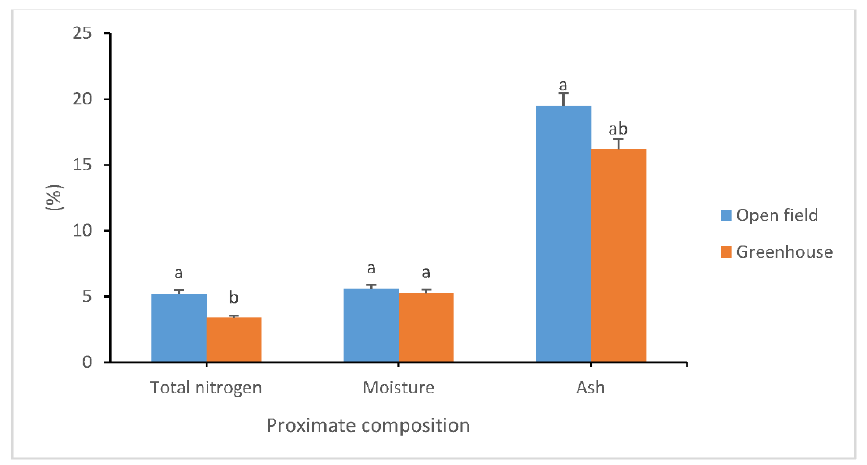
Figure 4. A comparative diagram showing the differences in proximate composition of A. Cruentus L. under open field (blue) versus greenhouse (orange) conditions a referrer to open field whilst b referrers to greenhouse.